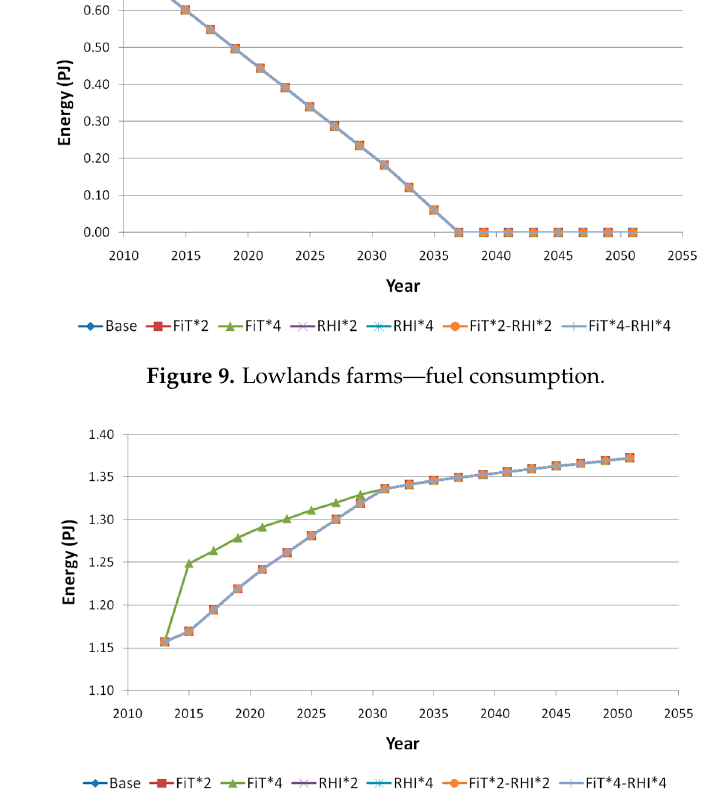
Figure 11. Lowlands farms—biogas production.